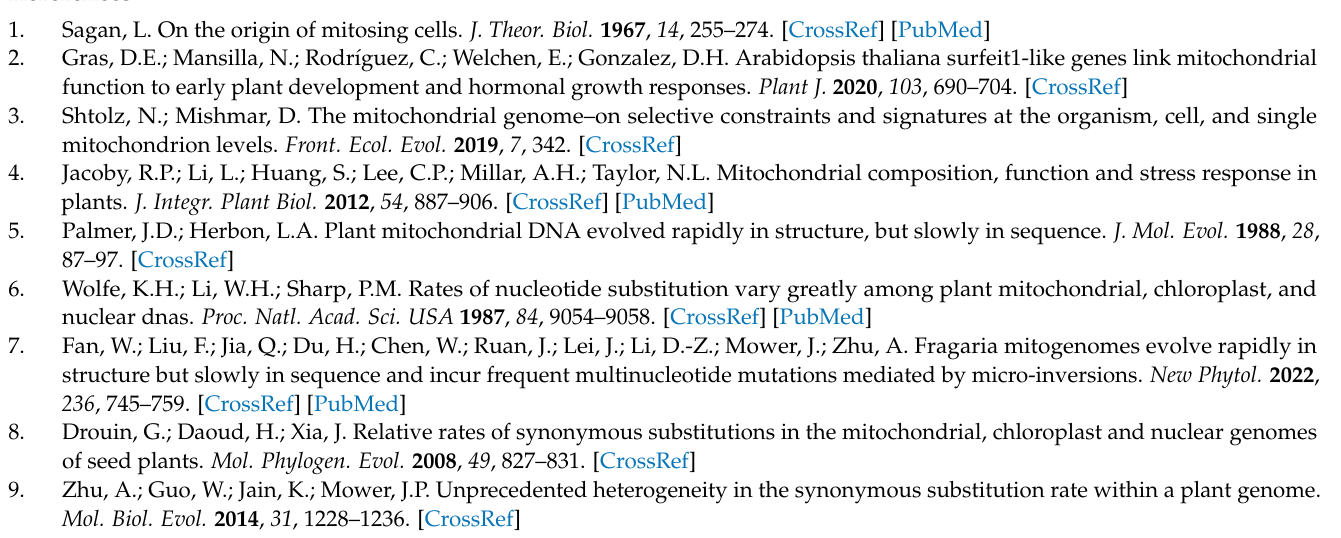
(A) The morphology of C. lancifolium . (B) Leaves of a C. lancifolium seedling were used for sequencing. (C) The morphology of C. macrorhizon . (D) Scapes and rhizomes of a C. macrorhizon seedling were used for sequencing. Figure S2. Diagrams of Illumina-based draft assemblies. (A) C. lancifolium mitogenome assembly. (B) C. macrorhizon mitogenome assembly. Contigs with high read coverage (>50 × ) are highlighted in green. Figure S3. Read coverage of the C. lancifolium and C. macrorhizon mitogenomes. (A) Read mapping plot of the C. lancifolium mitogenome. (B) Read mapping plot of the C. macrorhizon mitogenome. Figure S4. Evolution of boundary sequences of C. lancifolium repeats. (A) Alignment of boundary sequences surrounding a 212 bp conserved block of 18 homologous re- peats. (B) Alignment of boundary sequences surrounding a 149 bp conserved block of 6 homologous repeats. Figure S5. Evolution of boundary sequences of C. macrorhizon repeats. (A) Alignment of boundary sequences surrounding a 140 bp conserved block of 19 homologous repeats. (B) Alignment of boundary sequences surrounding a 149 bp conserved block of 6 homologous repeats. Figure S6. Identification and distribution of mitochondrial DNA of plastid origin (MIPT). (A) MIPT se- quences identified in chromosomes of the C. lancifolium mitogenome. (B) MIPT sequences identified in chromosomes of the C. macrorhizon mitogenome. CP: chloroplast; Chr: chromosome. Red lines link ho- mologous sequences with >95% similarity, and blue lines link homologous sequence with >90% simi- larity. Table S1. Sampled species and sequencing data for this study. Table S2. Lengths of mitogenome chromosomes. Table S3. Summary of the identified simple sequence repeats. Table S4. Syntenic relationship among C. lancifolium and C. macrorhizon